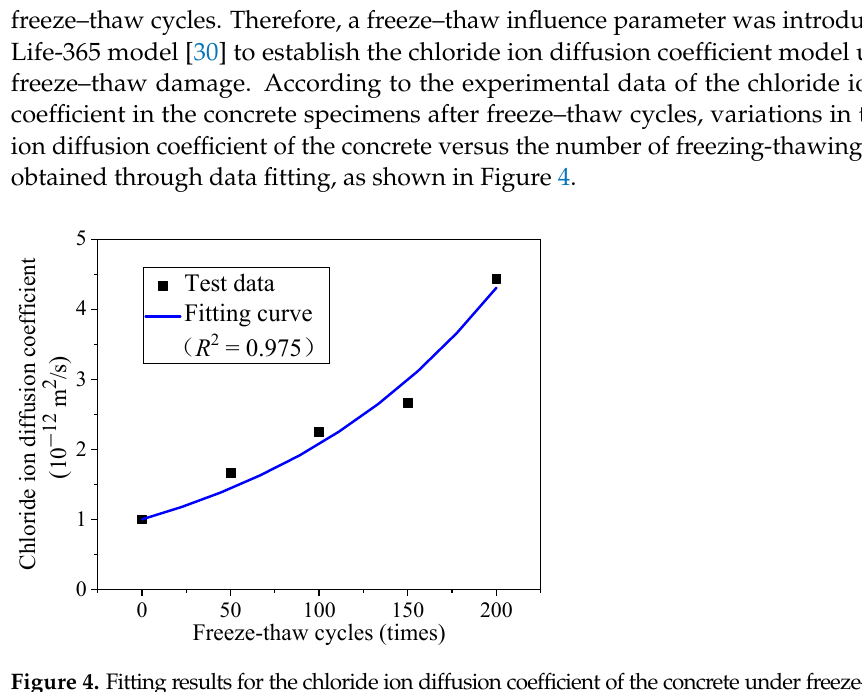
Figure 4. Fitting results for the chloride ion diffusion coefficient of the concrete under freeze–thaw cycles.